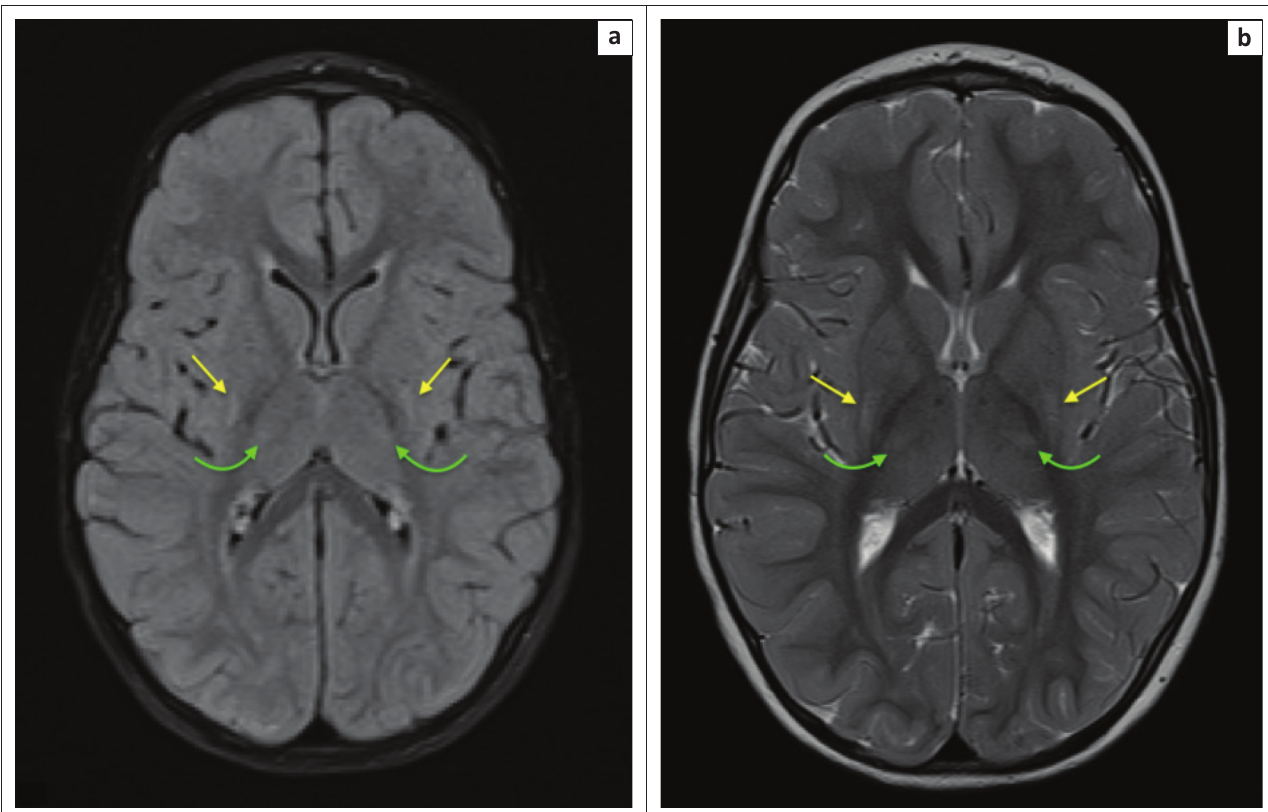
FIGURE 10: A 2-year-old female child with dystonic cerebral palsy. (a) An axial FLAIR sequence image and (b) an axial T2-weighted image demonstrating even more subtle signal abnormalities at the dorsal putamina (yellow arrows) and ventral thalami (green arrows). These changes can be very difficult to detect and may be omitted by the unsuspecting